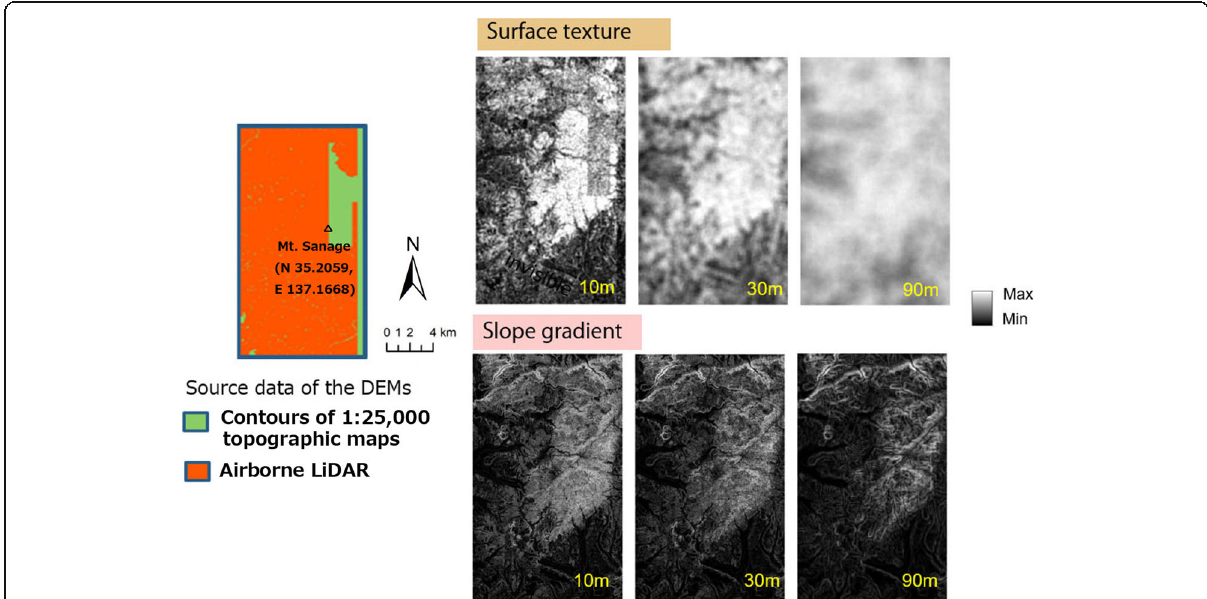
Fig. 3 Images of surface texture and slope gradient in different grid sizes of DEMs. Using the fundamental geospatial data (FGD; GSI), around Mt. Sanage, Aichi